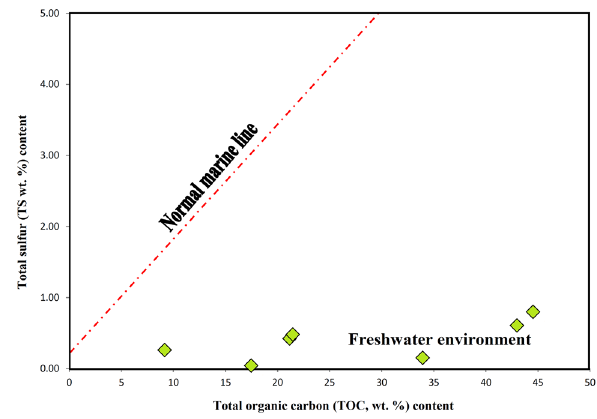
Fig. 8 Cross-plot of the sulfur and TOC contents (wt.%),